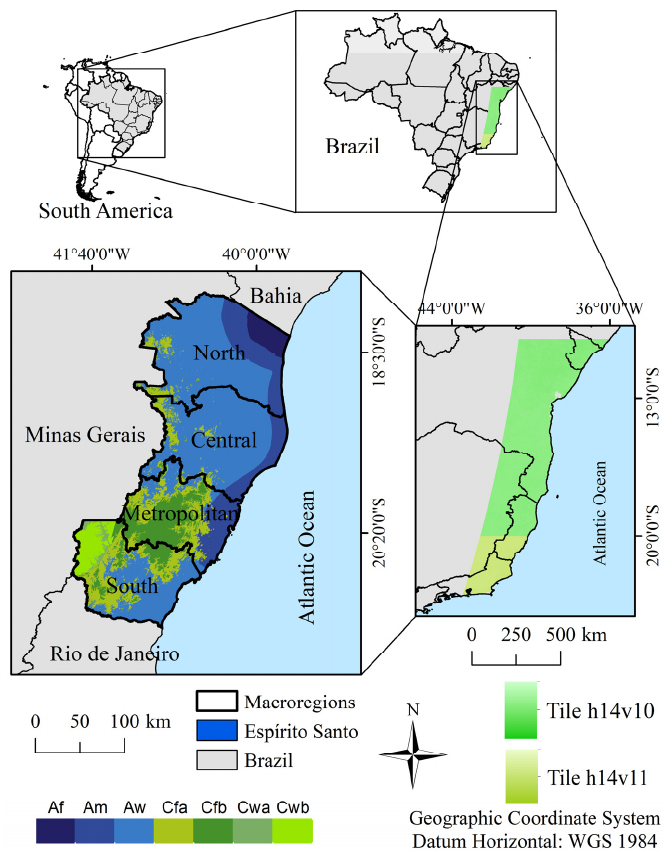
Figure 1. Location of the State of Espírito Santo and its planning macroregions, with the existing climate domains and images from the MODIS sensor, corresponding to the h14v10 and h14v11 tiles.